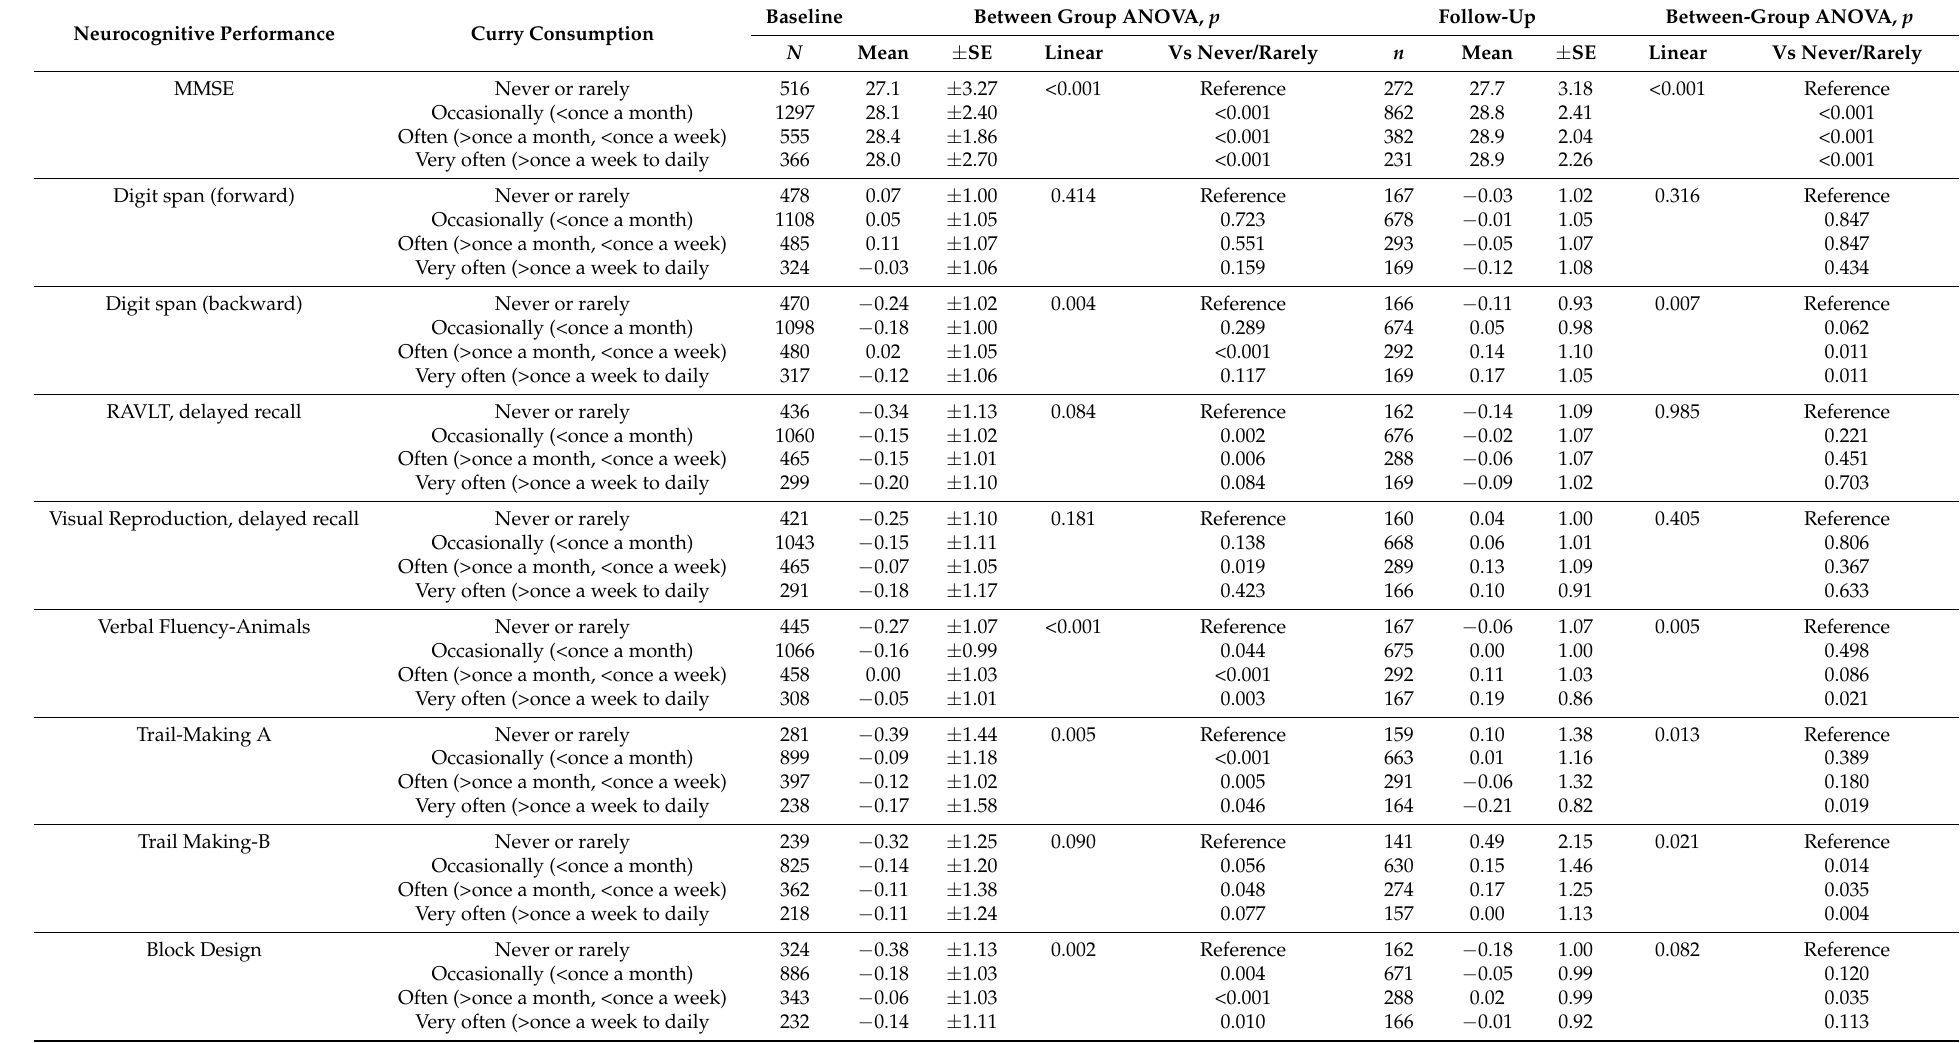
Table 2. Crude mean estimates of neurocognitive performance at baseline and follow-up by curry consumption